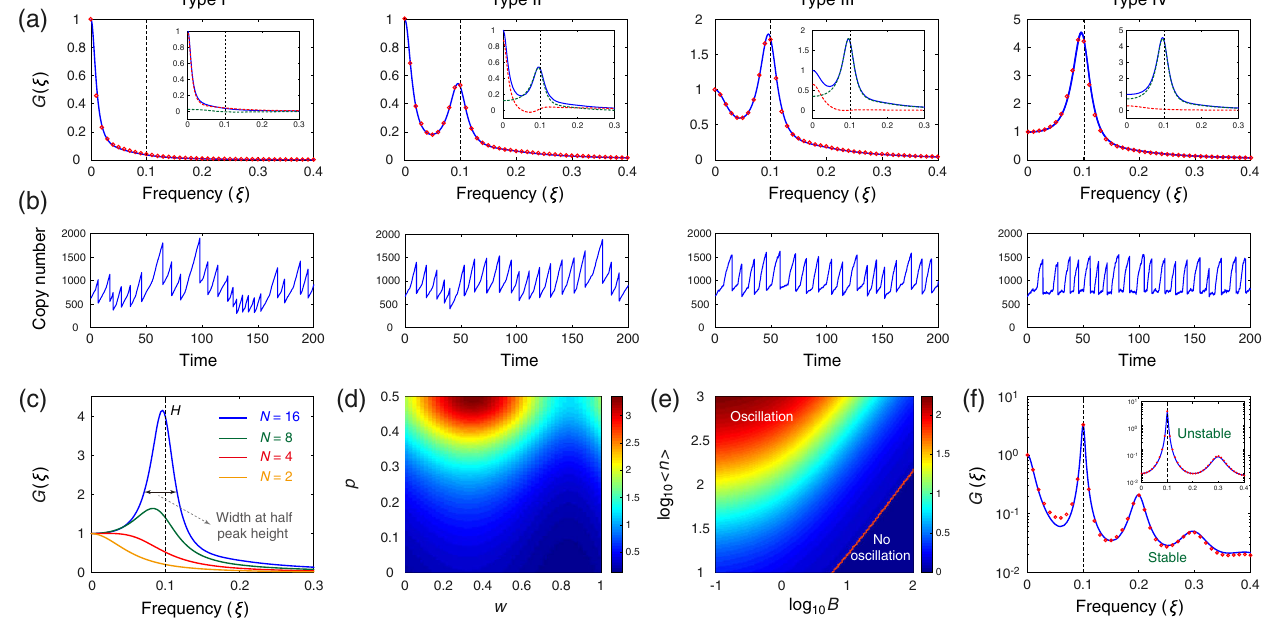
FIG. 2. Properties of the power spectrum. (a) For significant cell cycle duration variability, the spectra can be of four types. Note that the spectra are normalized such that G ð 0 Þ ¼ 1 . Theory (blue) matches stochastic simulations using Gillespie ’ s algorithm (red circles). Vertical dashed lines show the cell cycle frequency. Insets show the decomposition of the spectrum into two parts controlling the zero and off-zero peaks (red and green dashed curves, respectively). (b) Typical trajectories for the four types of spectra. (c) The off-zero peak becomes higher as cell cycle duration variability decreases ( N increases). (d),(e) Heat maps showing the dependence of the height of the off-zero peak (relative to the zero peak) on the parameters controlling the asymmetry of partitioning ( p ), the replication point ( w ), the burstiness of gene expression ( B ), and the mean number of gene product molecules ( h n i ). Type I spectra are observed in the region marked “ no oscillation. ” (f) For low cell cycle duration variability, higher-order harmonics of the cell cycle frequency appear; for midway replication, an unstable gene product, e.g., most mRNAs, has a spectrum with no peaks at even harmonics, while a stable gene product, e.g., most proteins, has peaks at all harmonics. Note that the blue curves are computed using the analytical expression given in Eq. (9), and the red circles are computed using the approximate expressions given in Eq. (13) for stable gene products and Eq. (F1) for unstable gene products. To make the higher-order peaks more apparent, the vertical axis is shown on the logarithmic scale. See Sec. S5 in the Supplemental Material [66] for the technical details of this